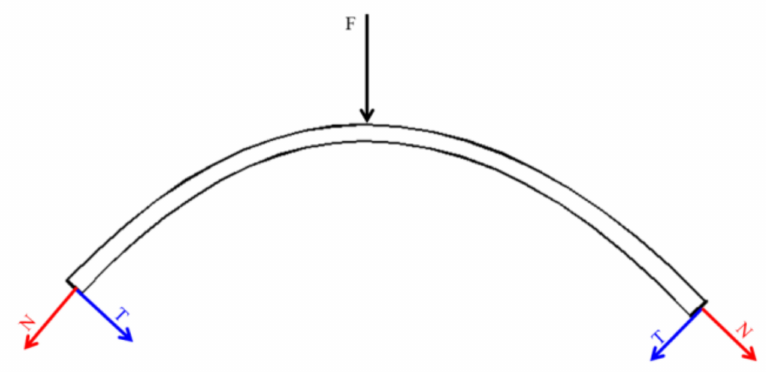
Figure 17. Force schematic for the analysis of antisliding stability at the base surface. Table 6. The magnitude of positive pressure and sliding force on the base surface for each arch contour.